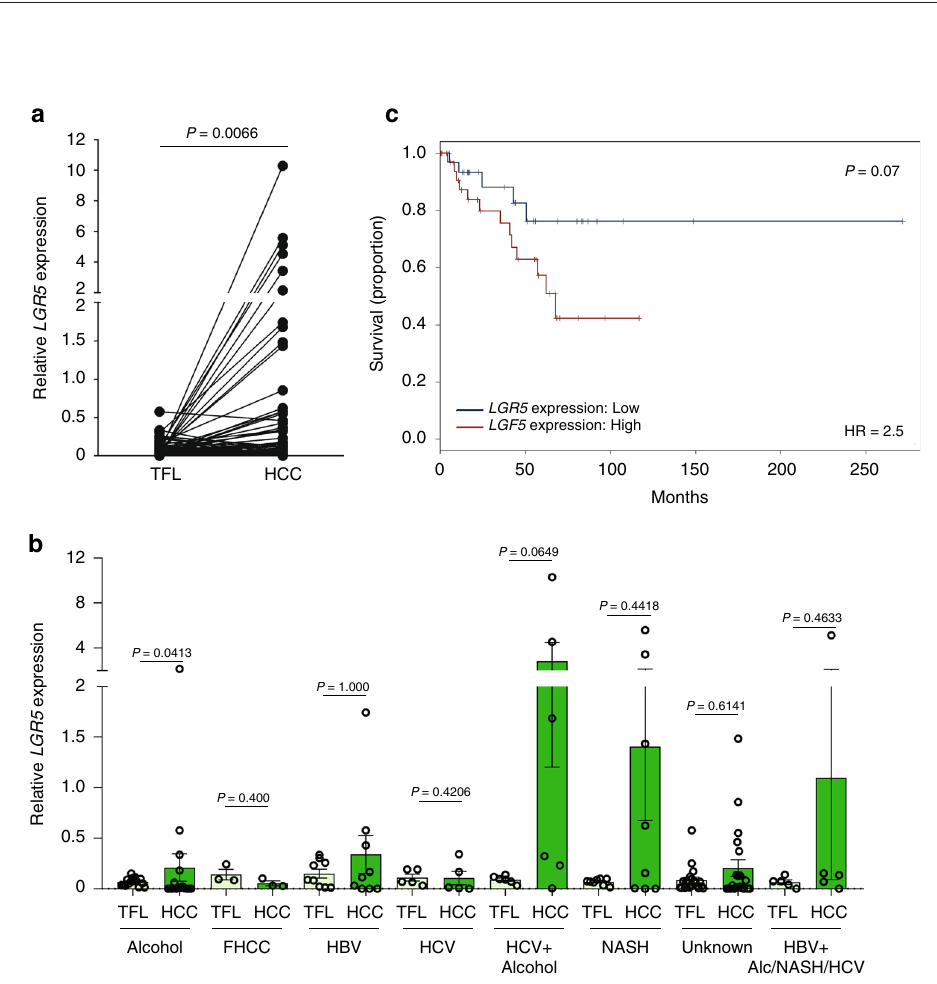
Fig. 1 Primary murine liver tumors are enriched with LGR5-expressing cells. a Principle of Lgr5 – DTR – GFP transgenic mouse strategy used in this study. b Principle of the experimental strategy used to induce primary murine tumors in the context of this study. c The percentage of LGR5 + cells, as determined by fl ow cytometry, is signi fi cantly higher in liver tumors from DEN-treated (7.29 ± 1.76%, n = 55) as compared with livers from untreated animals (0 ± 0%, n = 8) or injured livers from CCl 4 -treated animals (0.11 ± 0.022%, n = 17) (Welch test, P = 0.0001). d The percentage of LGR5 – GFP + cells is signi fi cantly increased in liver tumors (7.29 ± 1.76%, n = 55) as compared with the tumor-surrounding tissues (2.93 ± 1.15%, n = 34) of the same mice (Welch test, P = 0.0407). e Liver tumor-derived LGR5 – GFP + cells showed increased fl uorescence intensity when compared with LGR5 – GFP + cells derived from CCl 4 - injured livers. f Representative images showing LGR5 – GFP + cells as present in liver tumors. Yellow arrow: LGR5 – GFP + cell. DAPI: blue. Upper panels: scale bar = 50 µ m; lower panels: scale bar = 20 µ m. g , h Representative confocal images showing the expression of the cholangiocyte marker ( g , CK19, yellow) and the hepatocyte-speci fi c marker ( h , HNF4 α , red) in LGR5 – GFP-expressing cells, Scale bar = 50 µ m. Mean± SEM. Source data are provided as a Source Data fi le.